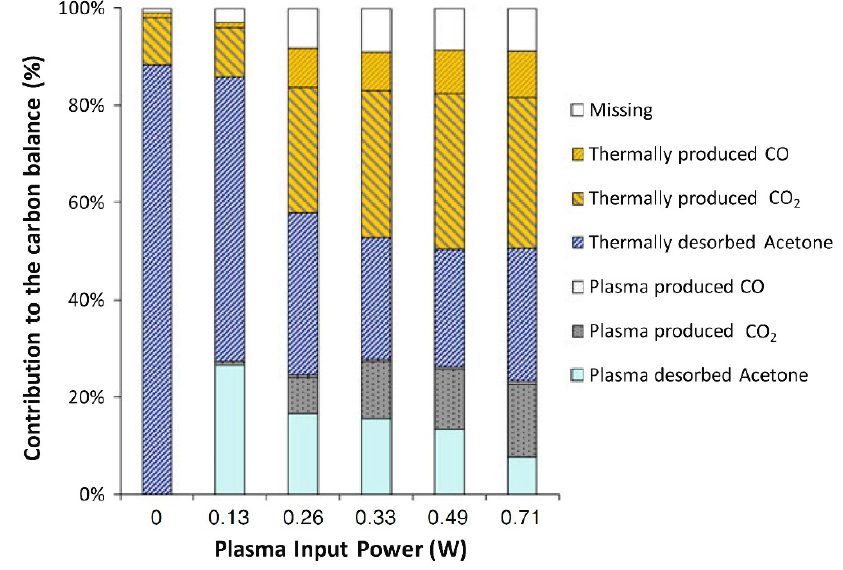
Figure 9. Contributions of CO, CO 2 and acetone to the carbon balance, calculated after successive plasma treatment and thermal treatment. Data are displayed for various plasma input powers. Reprinted from Ref. [47], with permission from